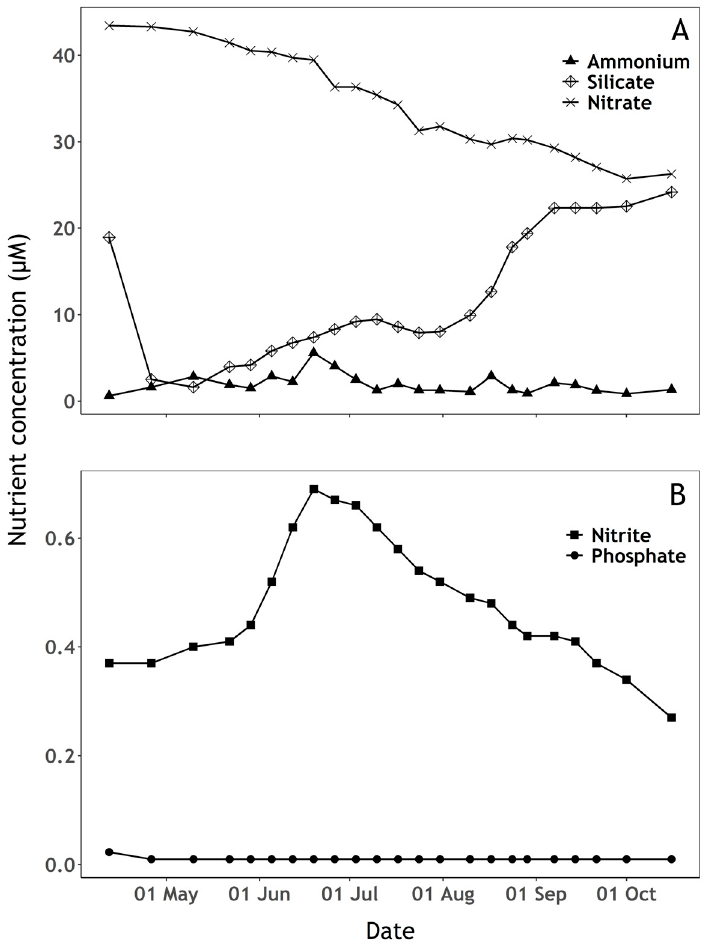
Figure 4. Nutrient concentrations (µM) over the sampling period. ( A ) Ammonium, silicate and nitrate concentration, ( B ) Nitrite and phosphate concentration. When the detection limit was not passed, phosphate concentrations below the limit of detection (0.02 µM) are displayed as 0.01 µM.